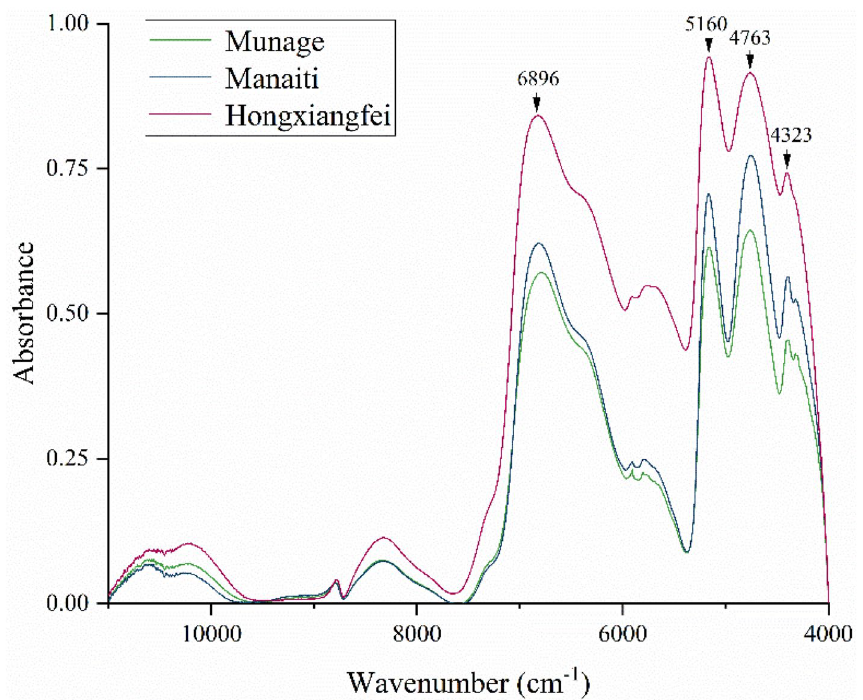
Figure 1. Average spectroscopy of raisin